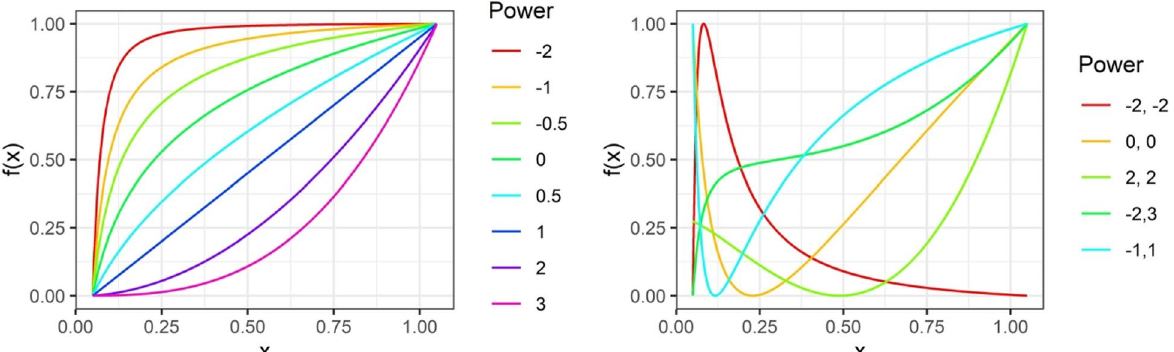
Fig. 1 Schematic diagram of eight FP1 (left panel) and a subset of the 36 FP2 (right panel)